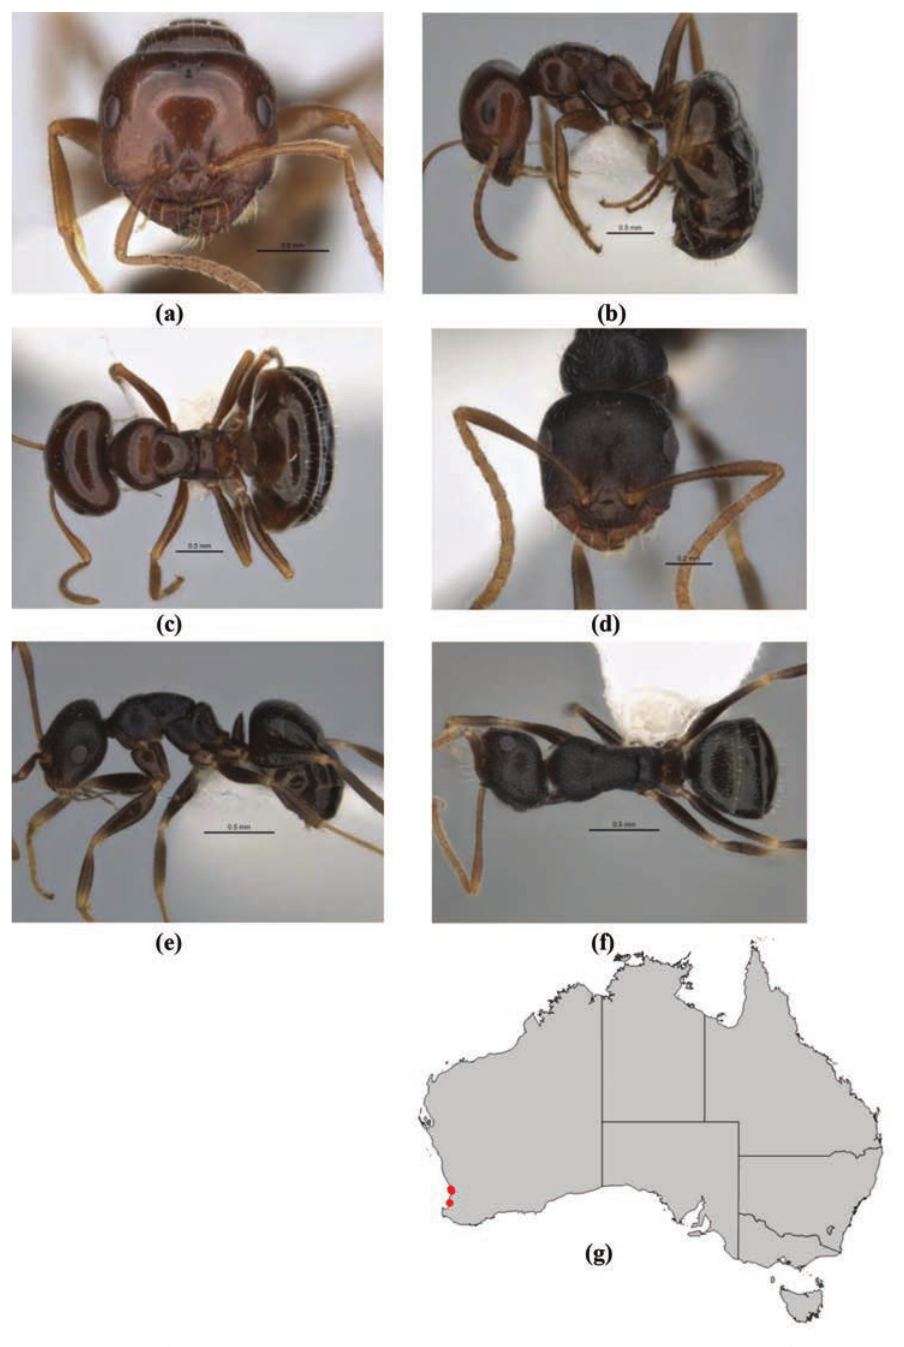
Figure 34. Melophorus cuneatus sp. n.: major worker paratype (JDM32-001958–top ant) frons ( a ), pro- file ( b ) and dorsum ( c ); minor worker holotype (JDM32-001958–bottom ant) frons ( d ), profile ( e ) and dorsum ( f ); distribution map for the species ( g ). Low resolution scale bars: 0.5 mm ( a–c, e, f ); 0.2 mm ( d